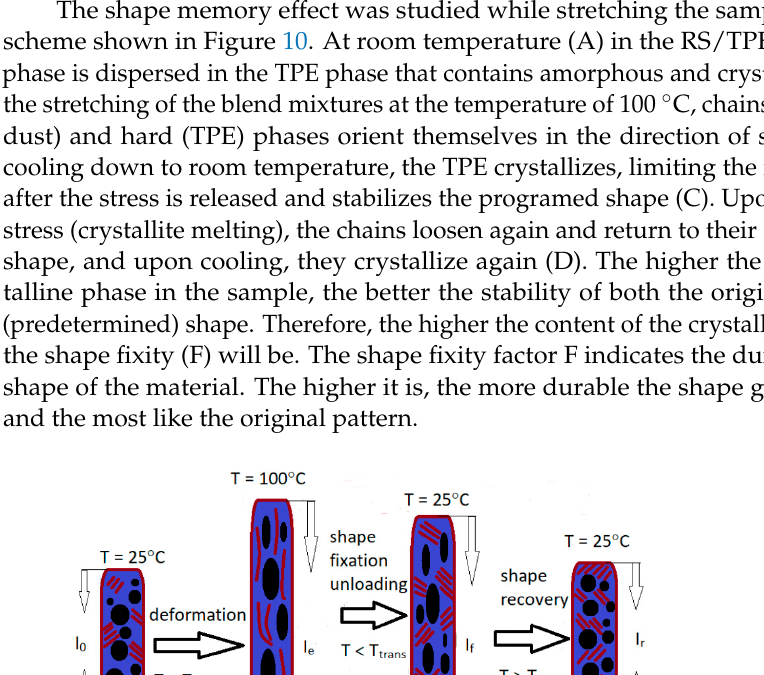
Figure 9. The microscopic images, after approximately 300x magnification of the RS/8452 ( a ); RS/8180 ( b ), RS/8411 ( c ).